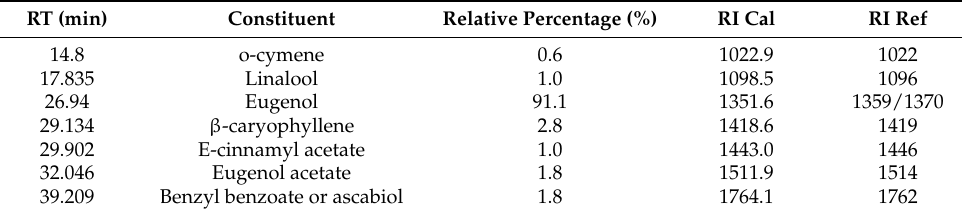
Table 2. Qualitative and quantitative analyses of Cinnamomum zeylanicum EO (CZEO). RT